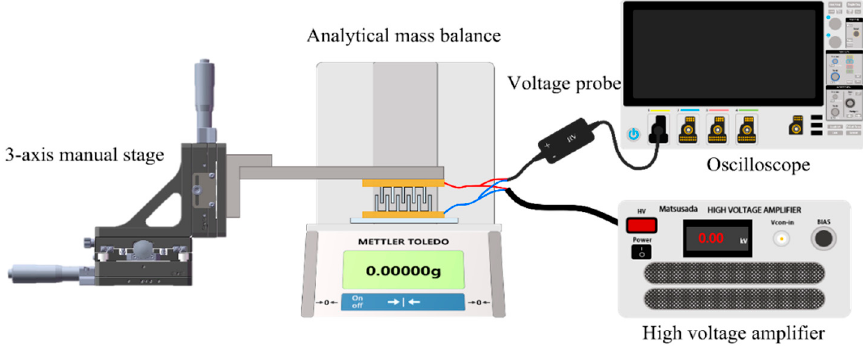
5 of 16 Figure 2. Drawing of the electrostatic combs defining structural parameters.